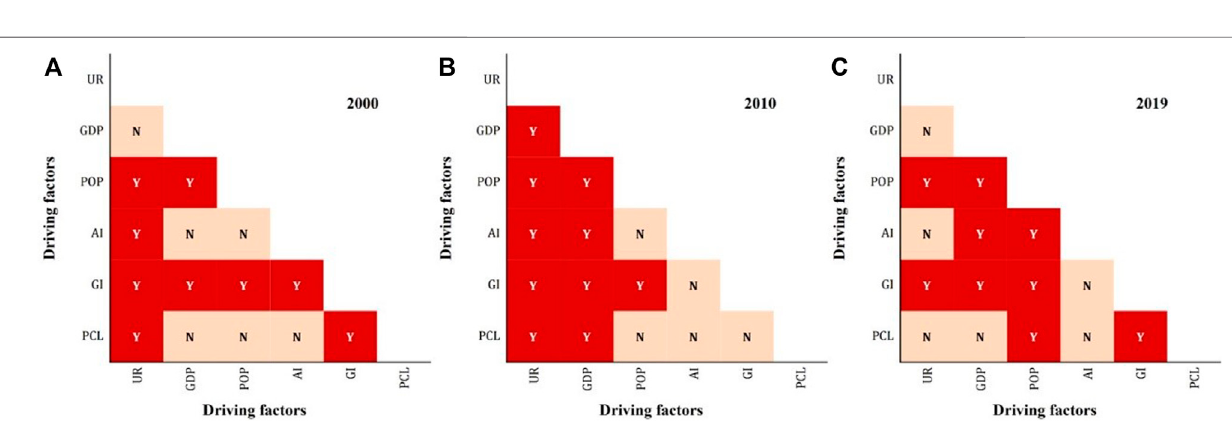
Frontiers in Environmental Science |